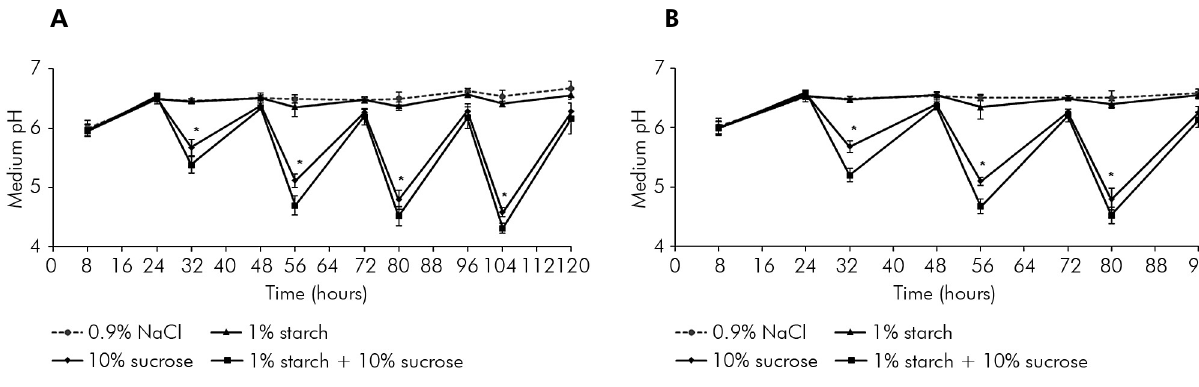
Figure 2. Acidogenicity of the biofilms (medium pH) formed on enamel (A) and dentine (B) slabs (mean ± SD, n = 9) according to time (h) and treatment (0.9% NaCl, 1% starch, 10% sucrose, 1% starch + 10% sucrose). *Significant differences between starch + sucrose and sucrose group (p <